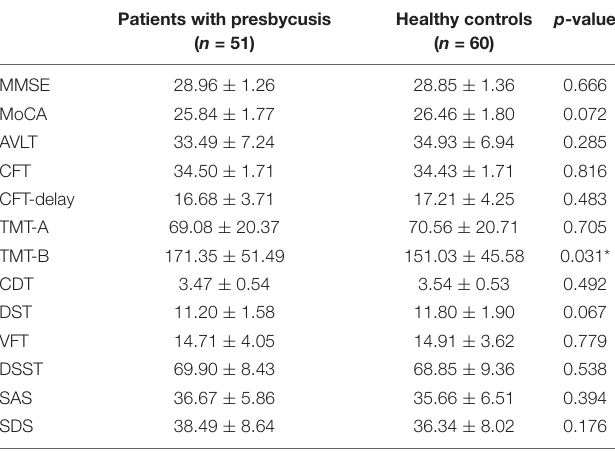
Healthy controls p ( n = 60)